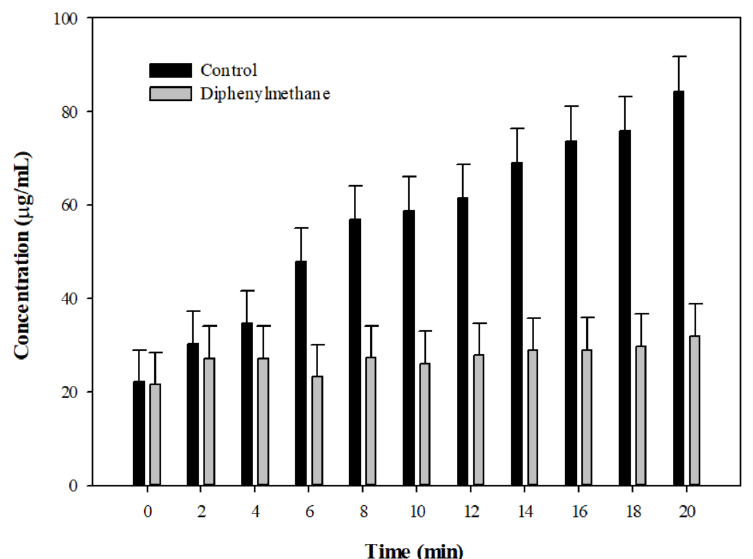
Figure 4. The erythromycin efflux activity of E . coli Kam3-AcrB was detected by using MALDI-TOF MS in the presence of diphenyl methane. The intensity was plotted at the main peak at m / z 738.35 of erythromycin and the detection period was 20 min. Values are expressed as mean ± SD ( n = 3).